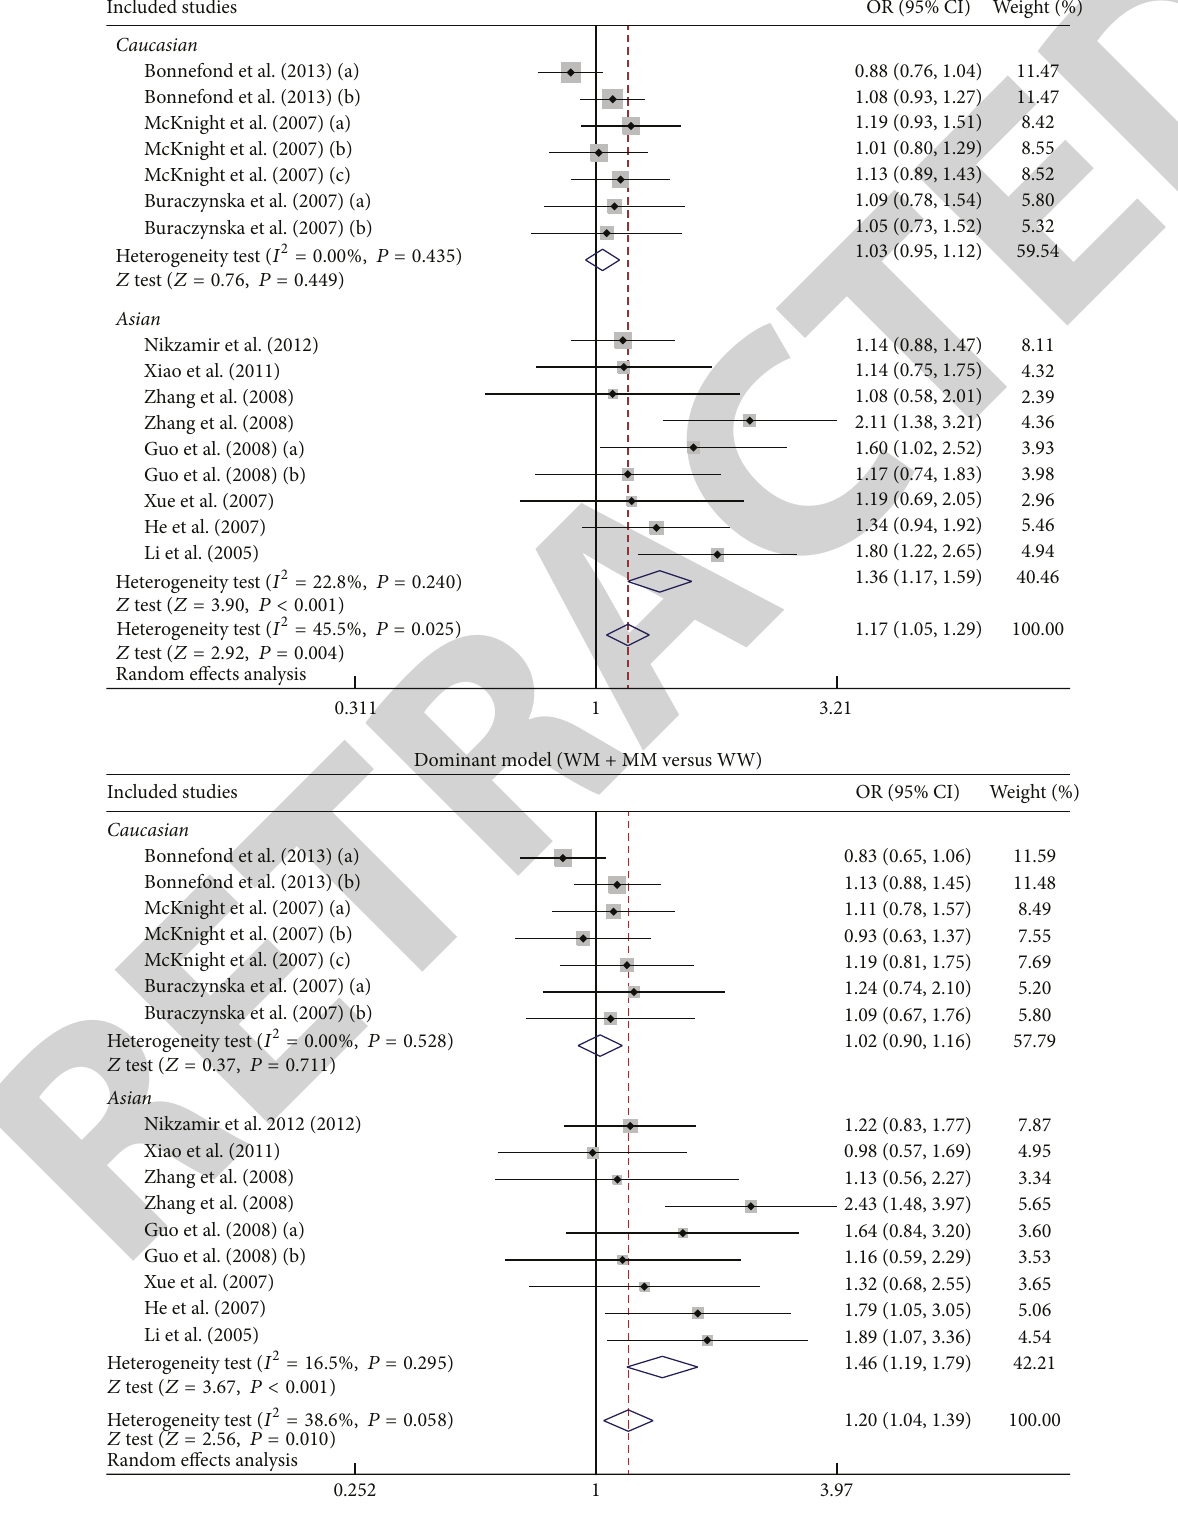
Figure 4: Subgroup analyses by ethnicity of the relationships of VEGF genetic polymorphisms with the risk of diabetic nephropathy in patients with diabetes mellitus under the allele and dominant